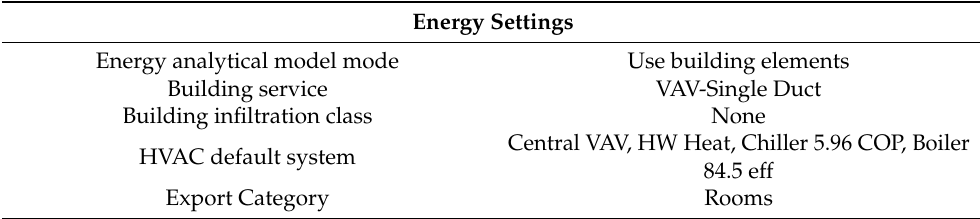
Table 3. Summary of building energy settings.